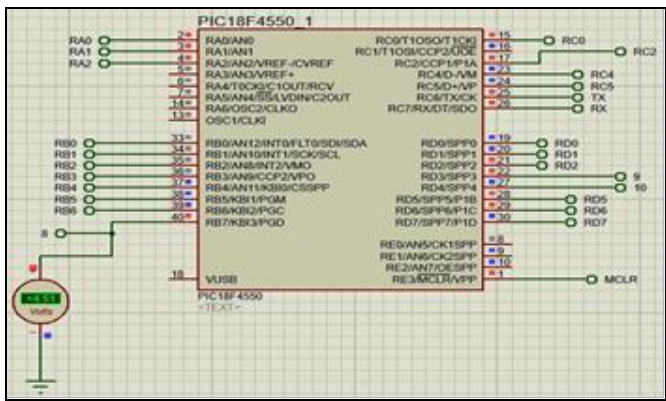
Figura 5: Micro controlador